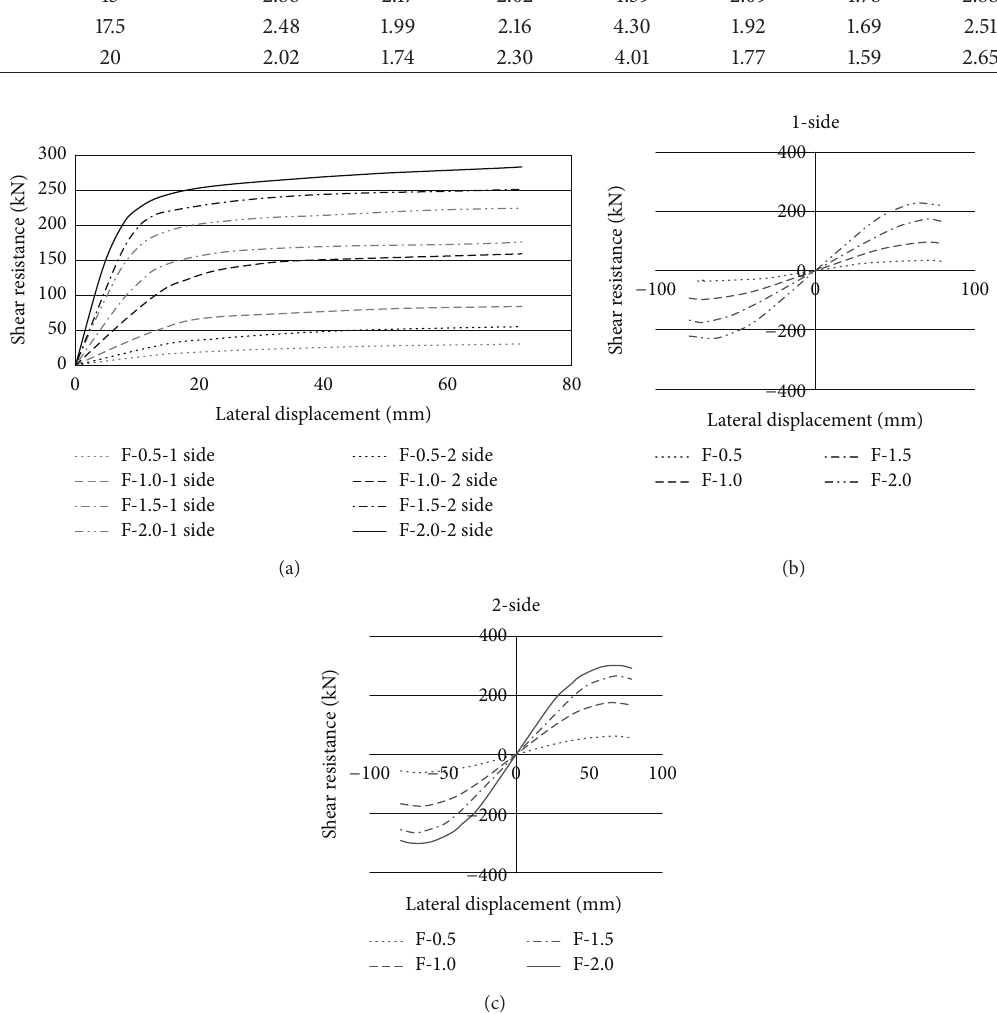
Figure 8: Curves of specimens F. (a) Monotonic curves. (b) Hysteretic envelope curves 1-side. (c) Hysteretic envelope curves